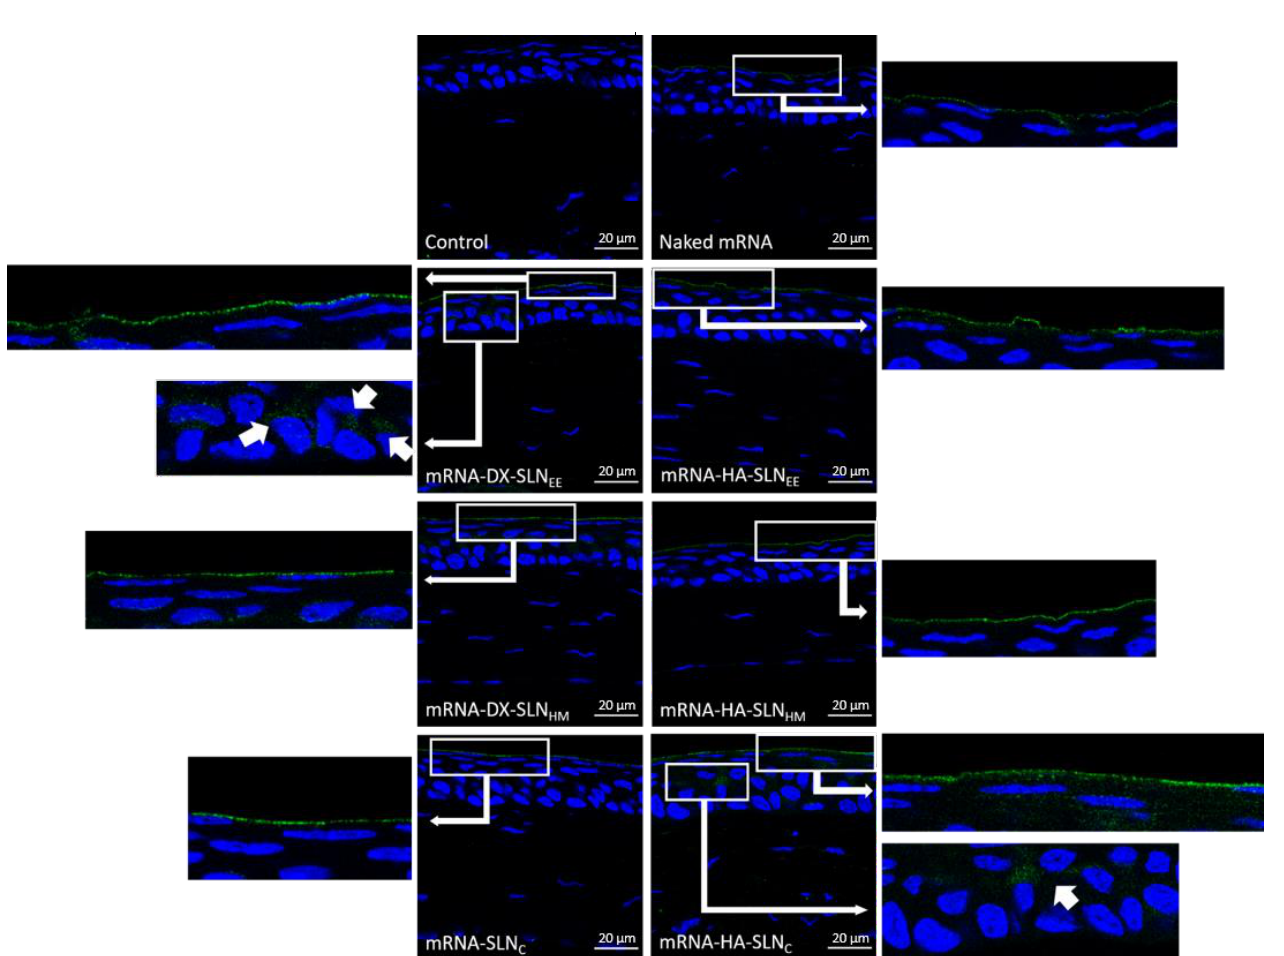
Figure 7. In vivo corneal transfection in mice 24 h after the administration of mRNA-vectors encoding human IL-10 with the viscosifier PVA (63×). Blue: nuclei stained with DAPI. Green:IL-10 detected by immunofluorescence with the secondary antibody labeled with Alexa Fluor 488. Scale bar: 20 µm. DX: dextran; HA: hyaluronic acid; SLN EE : solid lipid